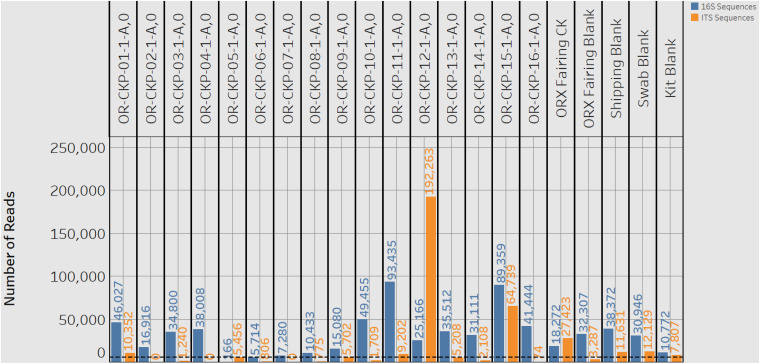
A plot showing the number of 16S rRNA gene (blue bars) and ITS (orange bars) reads or sequences for each sample. A black dashed line marks the detection limit for 16S rRNA gene sequences of 5,611 sequences. One 16S rRNA gene sample (CKP-05) and nine ITS samples fell below this limit of detection.